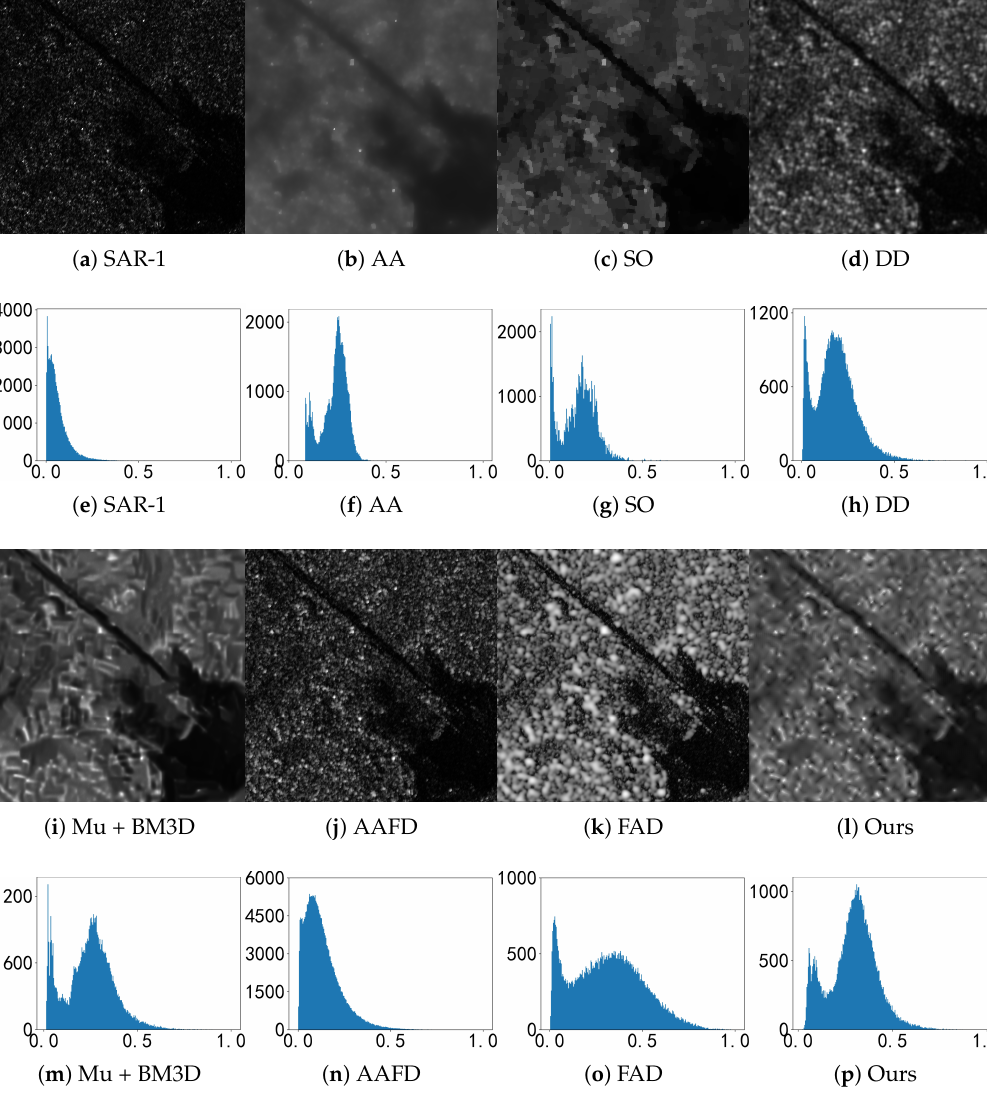
Figure 10. Denoised results and the corresponding